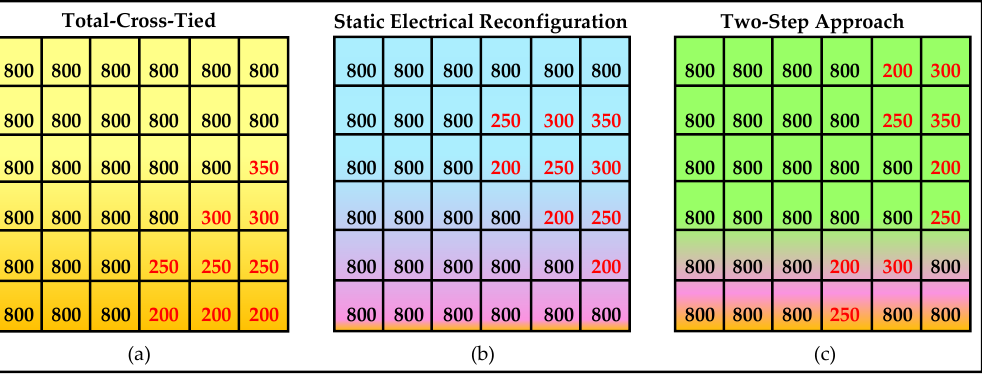
Figure 9. Irradiance received by the 6 × 6 PV array during partial shading S2 for ( a ) conventional, hybrid and TCT, ( b ) static electrical reconfiguration (shade dispersion), and ( c ) the two-step approach (shade dispersion). Table 2. Summarized mathematical estimation of current, voltage and power values of the PV array